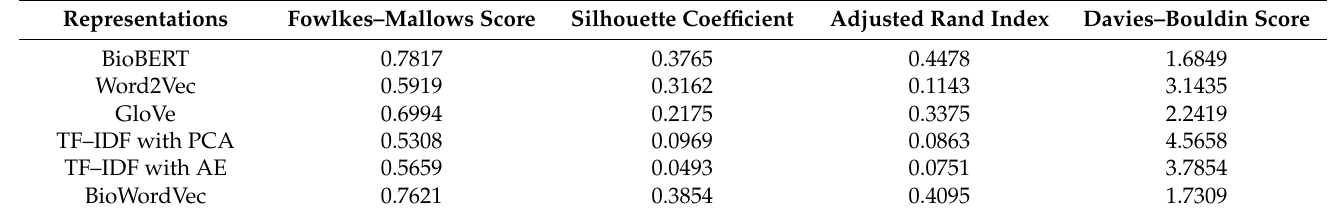
Table 3. Evaluation results of Gaussian-mixture-model-based clustering for biomedical